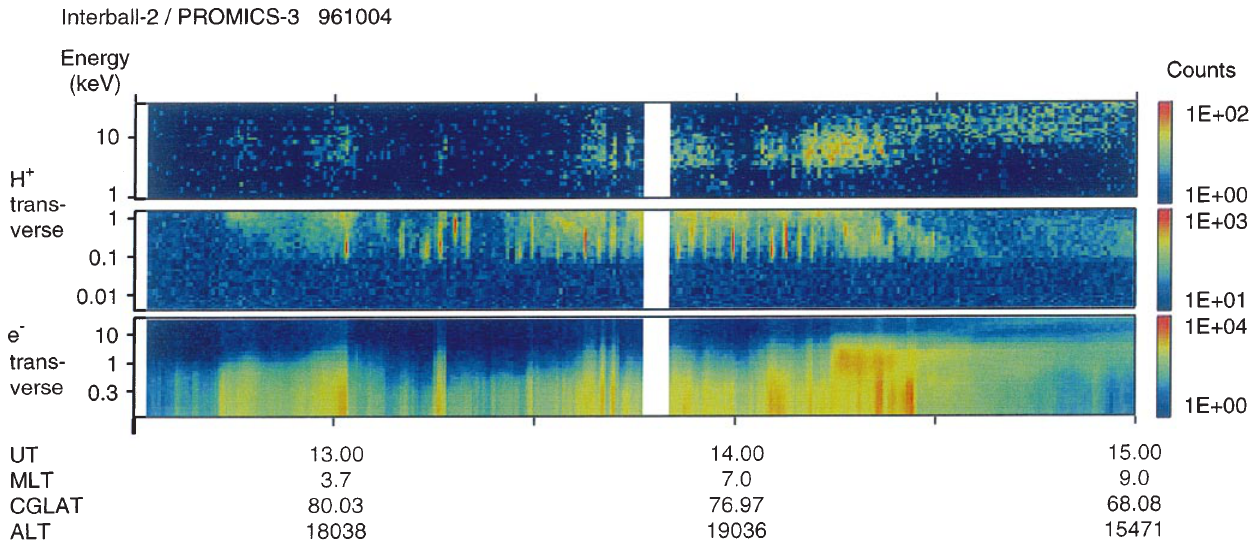
Fig. 15. Spectrogram from Interball-2 showing the period between 1230 and 1500 UT on October 4, 1996. Dispersion structures were detected between 1330 and